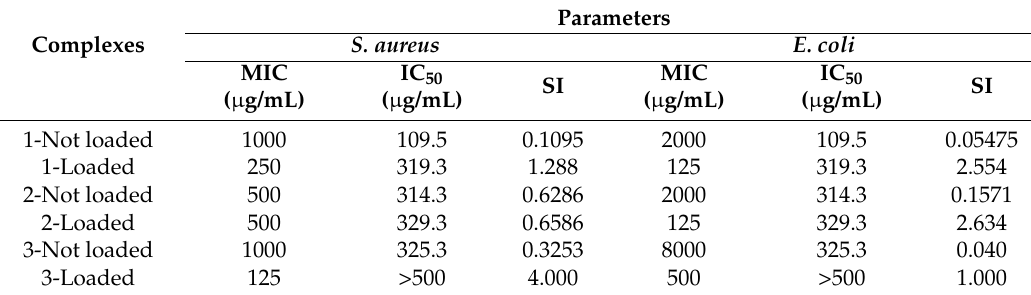
Table 4. Results of biological assessments (MIC and IC 50 ) and determination of the selectivity index (SI) of the free copper(II) complexes or those loaded into the nanostructured lipid system against S. aureus and E.